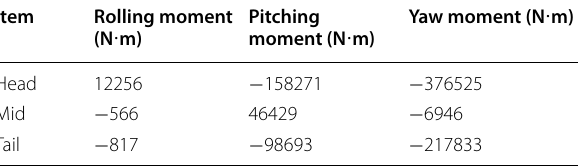
Table 5 Aerodynamic moments of full-size